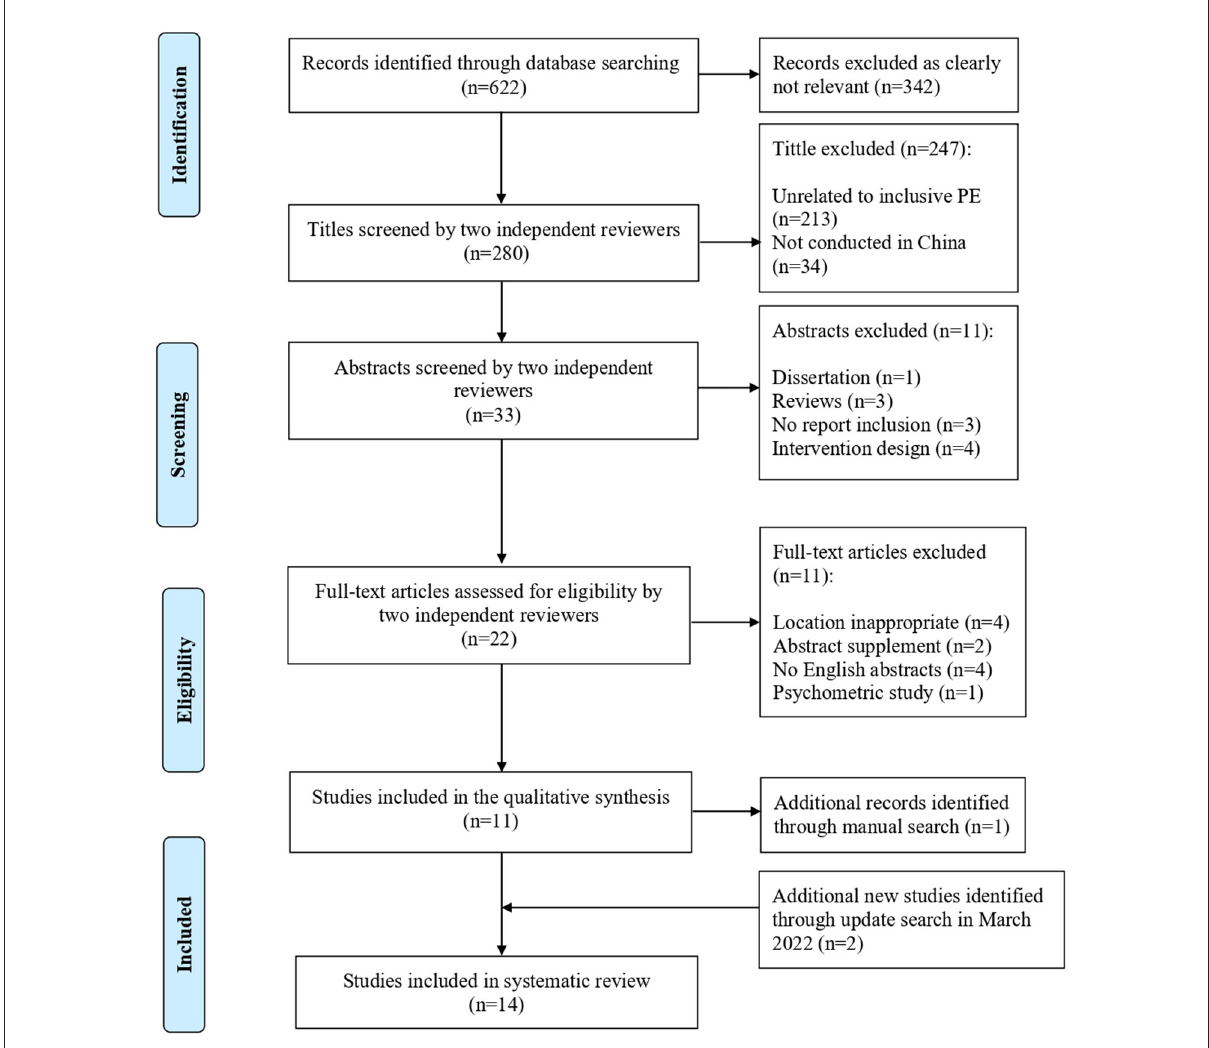
FIGURE2 Flow diagram showing the study selection